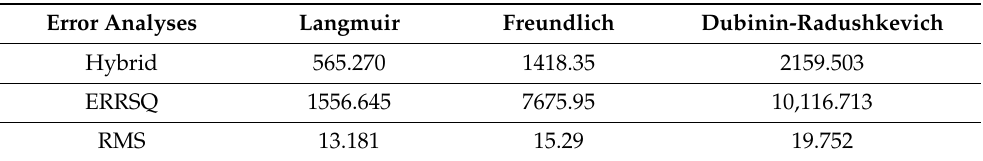
Table 4. Values of three different error analyses of isotherm models for the adsorption of IV2R by P. capillacea